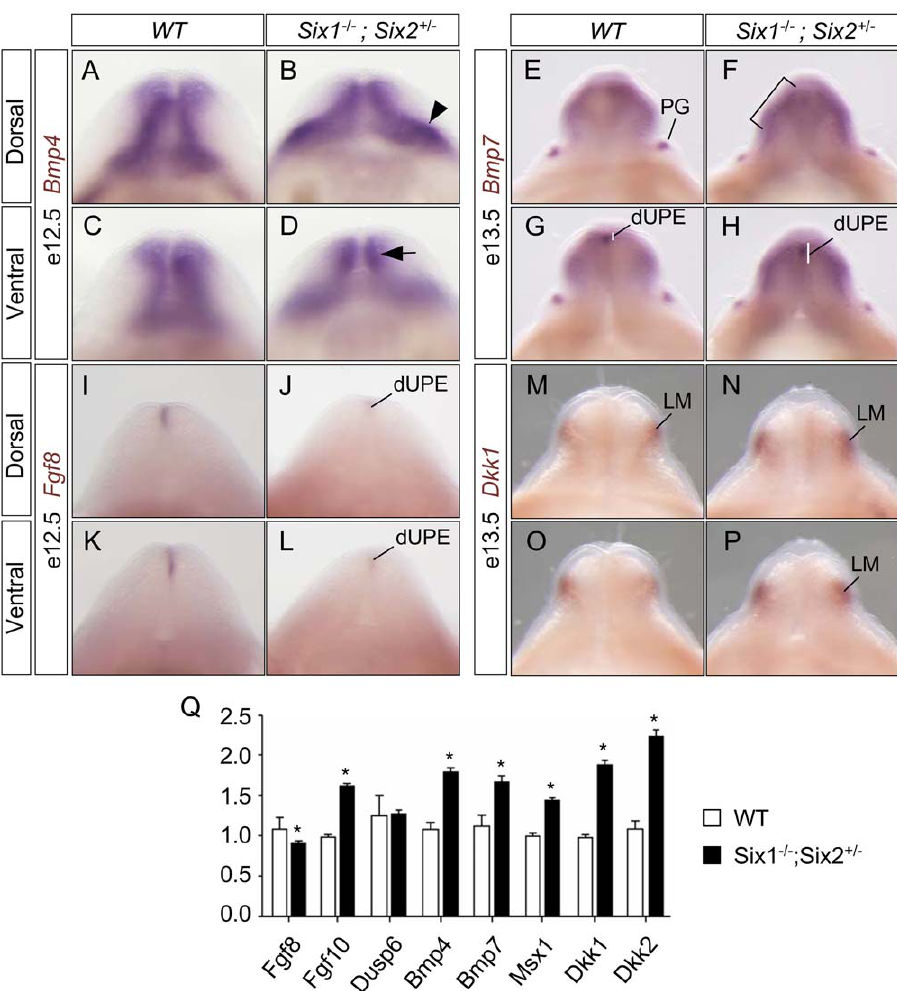
Figure 8. Aberrant expression of signal molecules during urogenital development in Six1;Six2 compound mutants. ( A–P ) Whole mount in situ hybridization of genital tubercles using gene-specific probes of Bmp4 , Bmp7 , Fgf8 , and Dkk1 . ( Q ) Real time quantitative PCR analysis of gene expression levels of micro-dissected genital tubercle tissue at e11.5. Arrow, ventral distal mesenchyme; arrowhead, dorsal lateral mesenchyme; bracket, enhanced expression of Bmp7 ; dUPE, distal urethral plate epithelium; LM, lateral mesenchyme; PG, preputial